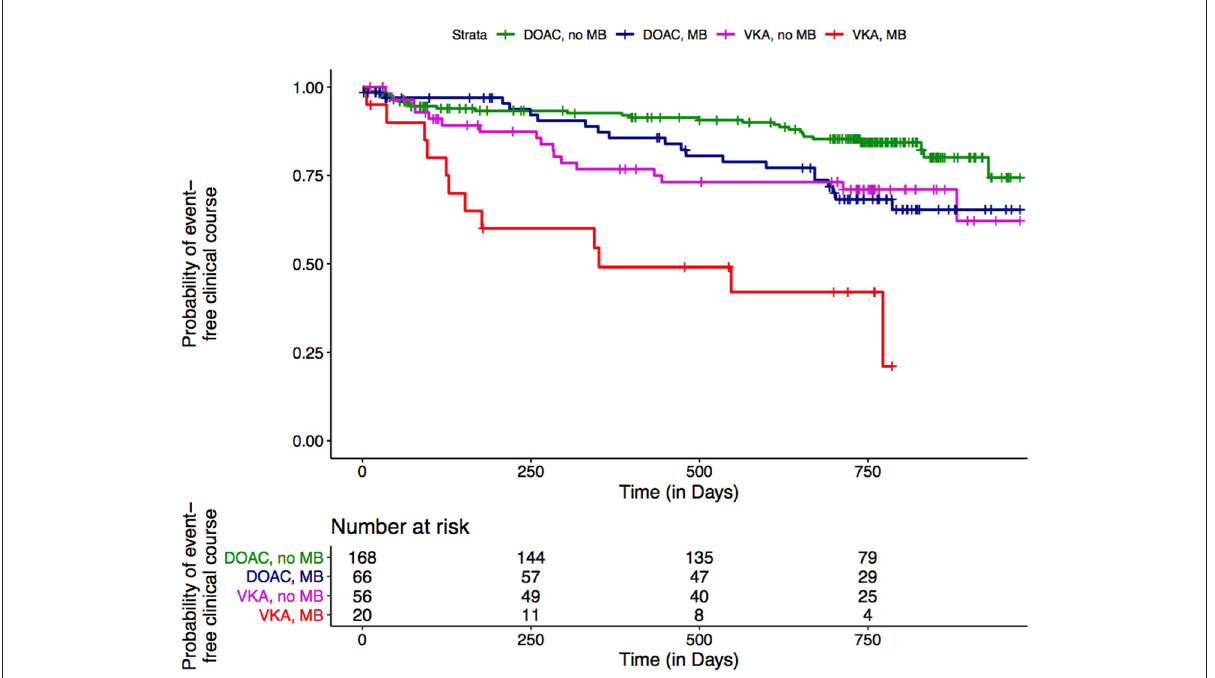
FIGURE1 Non-parametric estimation of the survival curves for combined outcome events by type of OAC and